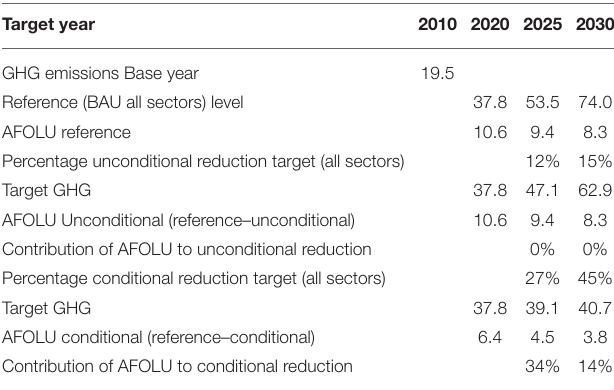
TABLE 4 | Ghana’s baseline of 2015 NDC commitments and contribution of the climate actions analyzed in the present